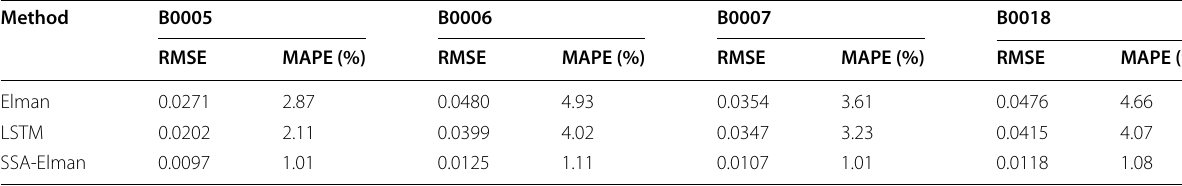
Table 8 The estimation error of 50% training data RMSE and MAPE Method